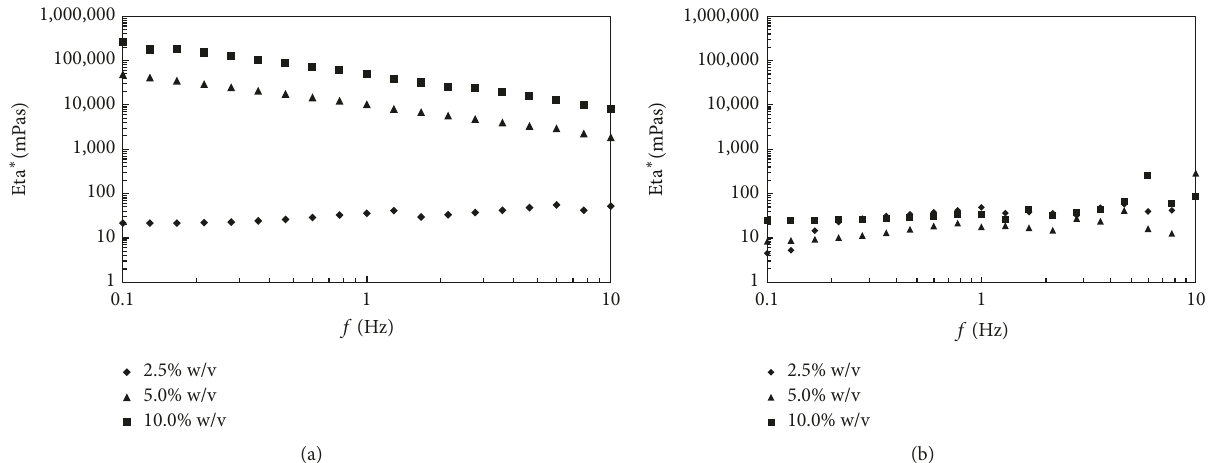
Figure 7: Complex viscosity, Eta ∗ , as a function of frequency: (a) the purified dextran from W. confusa R003; (b) commercial dextran